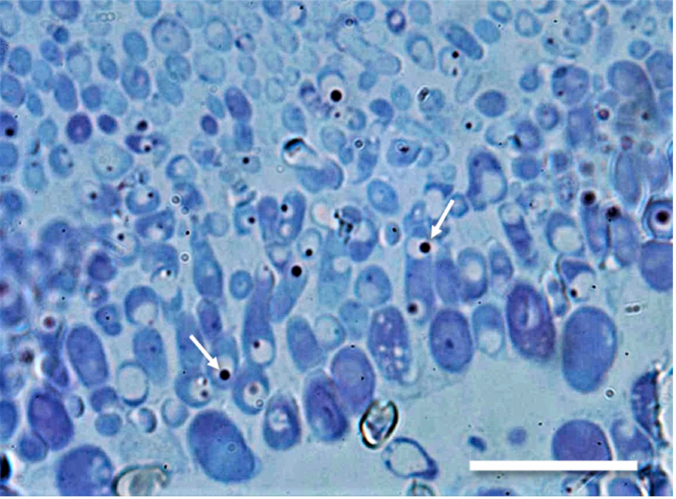
Figure 7. Semithin section stained with toluidine blue of A. aegerita terminal hyphae in a fruiting body observed by bright field microscopy: numerous dark dots (arrows) are present inside the vacuoles. Part of this section has been processed for immunolabelling and examined by TEM (see Figure 8). Bar is 10 µ